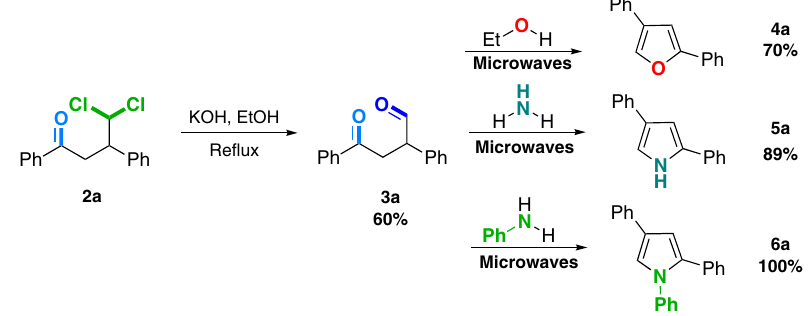
Fig. 4 Preparation of different heterocyclic bioactive compounds from enones. Isolated yields are